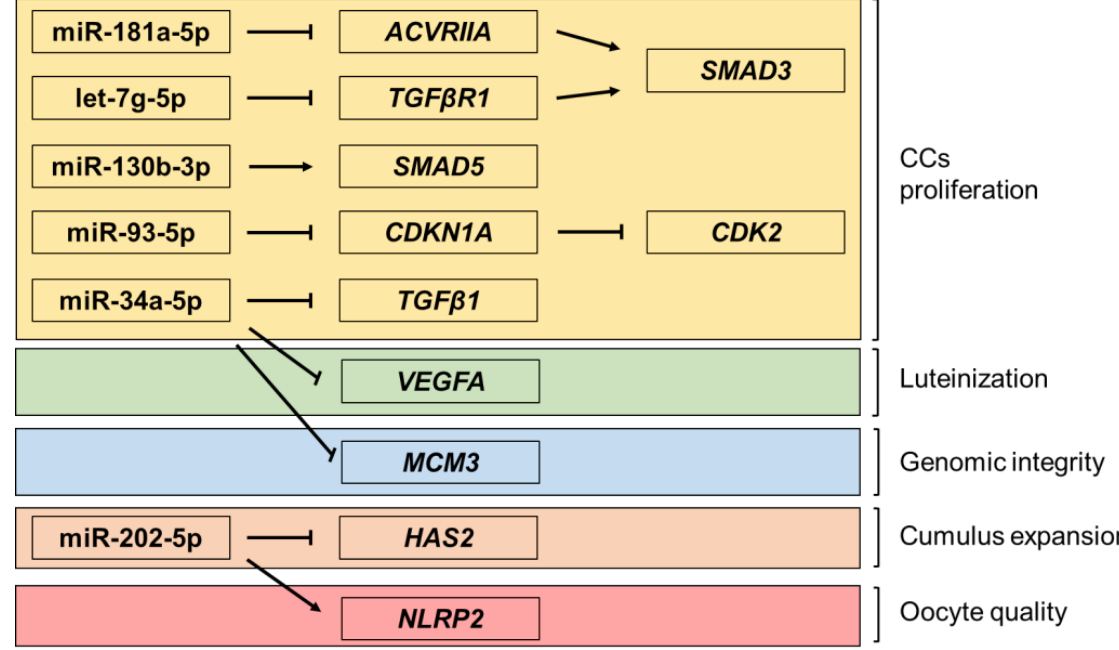
Figure 1. Scheme displaying the miRNAs selected in the study, together with their related genes and the pathways they are involved in. ACVRIIA : activin A receptor type 2A; SMAD3 : smad family member 3; TGFβR1 : transforming growth factor beta receptor 1; SMAD5 : smad family member 5; CDKN1A : cyclin dependent kinase inhibitor 1A; CDK2 : cyclin dependent kinase 2; TGFβ1 : transforming growth factor beta 1; VEGFA : vascular endothelial growth factor; MCM3 minichromosome maintenance complex component 3; HAS2 : hyaluronan synthase; NLRP2: NLR family pyrin domain containing 2.